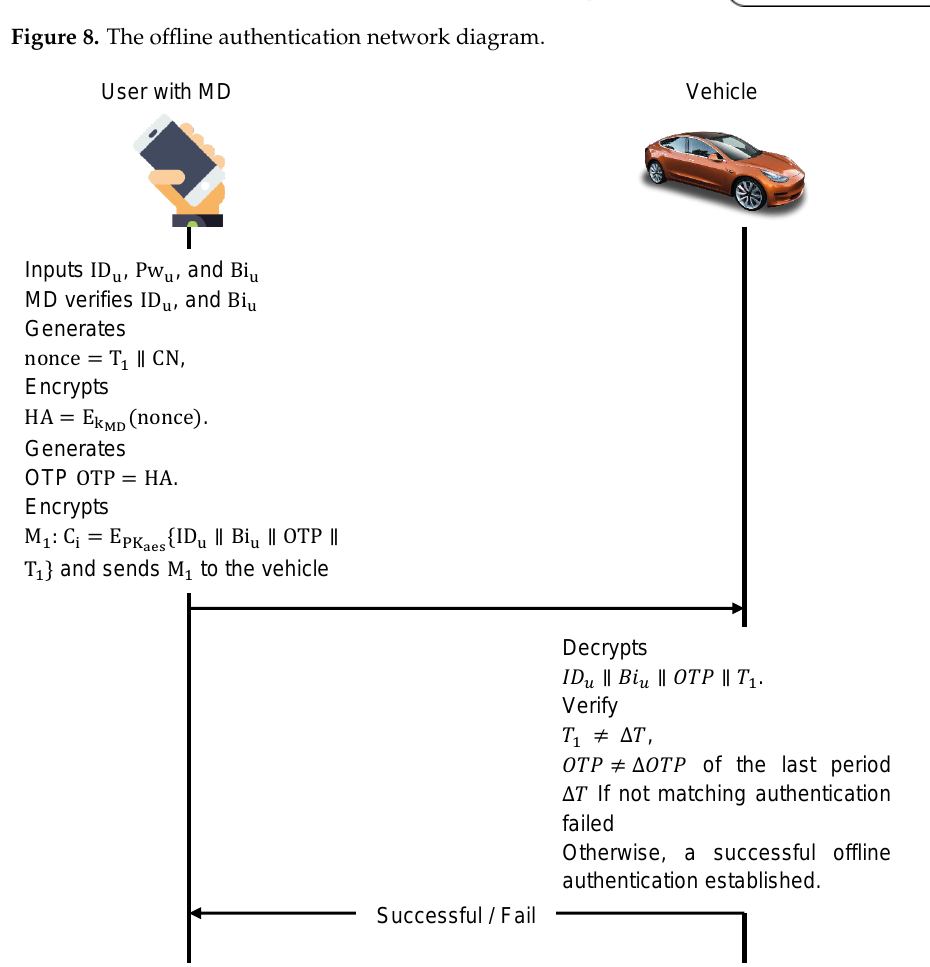
Figure 9. The offline authentication